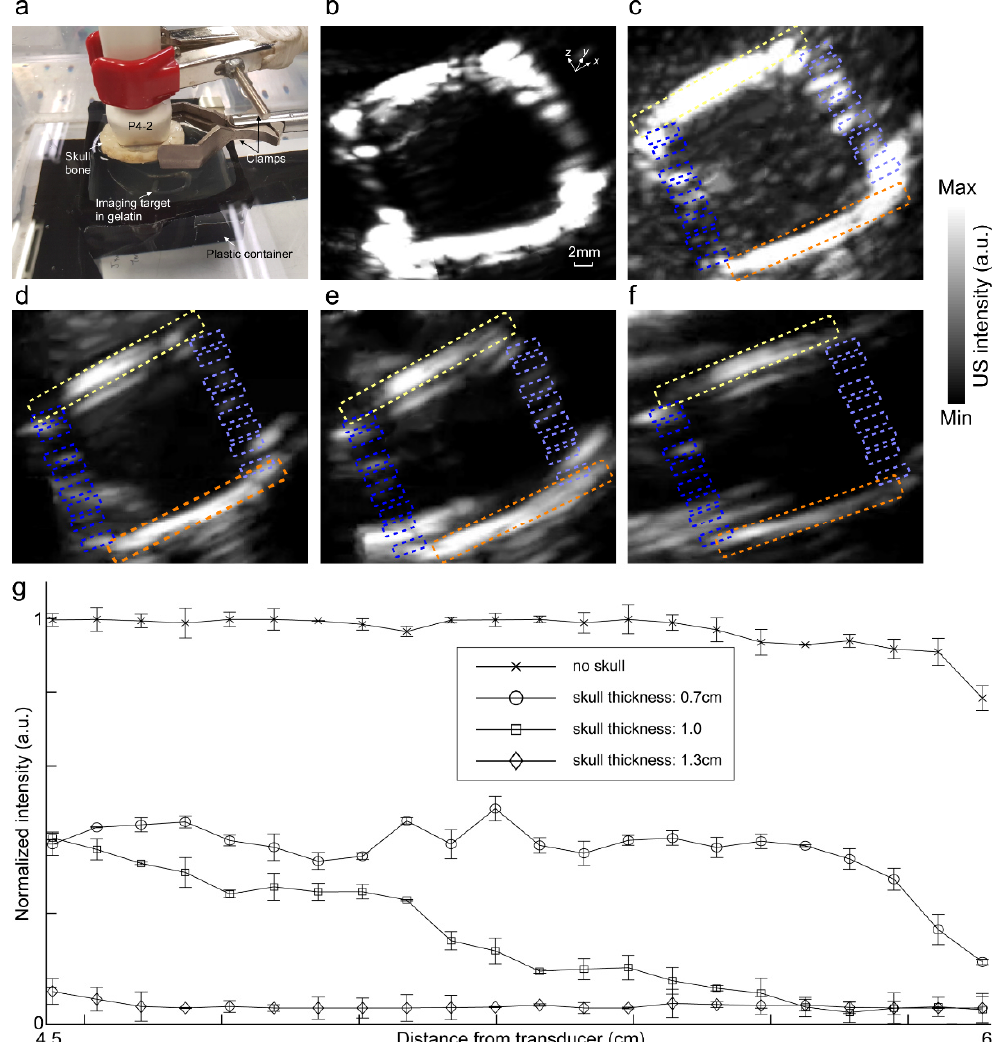
Figure 6. Image intensity attenuation and distortion analysis in a transcranial ultrasound imaging experiment. ( a ) Experimental setup. US image of the square imaging target ( b ) in gelatin and ( c ) in gelatin with the fiber mixture. Ultrasound images of the square imaging target in the gelatin with the fiber mixture through a skull piece with a thickness of ( d ) 0.7, ( e ) 1.0, and ( f ) 1.3 mm. ( g ) Average line profiles within the ROIs indicated with (i) light green, (ii) dark blue, (iii) light blue, and (iv) orange dotted boxes depicted in ( c – f ). Light green and orange ROIs are at the same depth from the transducer. This distance increases from the light to dark blue ROIs from 4.5 to 6 cm. The transducer was at the distance of 1.5 cm from the skull, and the skull was at the distance of 3 cm from the imaging target. ROI: region of interest Table 2. Summary of the quantitative evaluation of PA imaging through the skull in gelatin with the fiber mixture when the acoustic propagation path is blocked with skull pieces with different thicknesses.